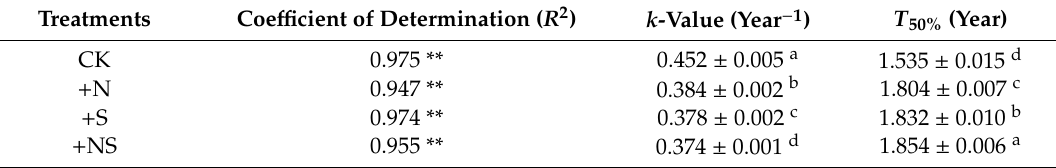
** Denotes highly significant ( p < 0.01). Di ff erent lowercase letters in the superscript denote significant di ff erences between di ff erent treatments ( p < 0.05; Fisher’s least significant di ff erence (LSD) test adjusted using the Bonferroni correction). Values are the averages of three plot replicates ± standard deviations. Treatment abbreviations are provided in Figure 2.